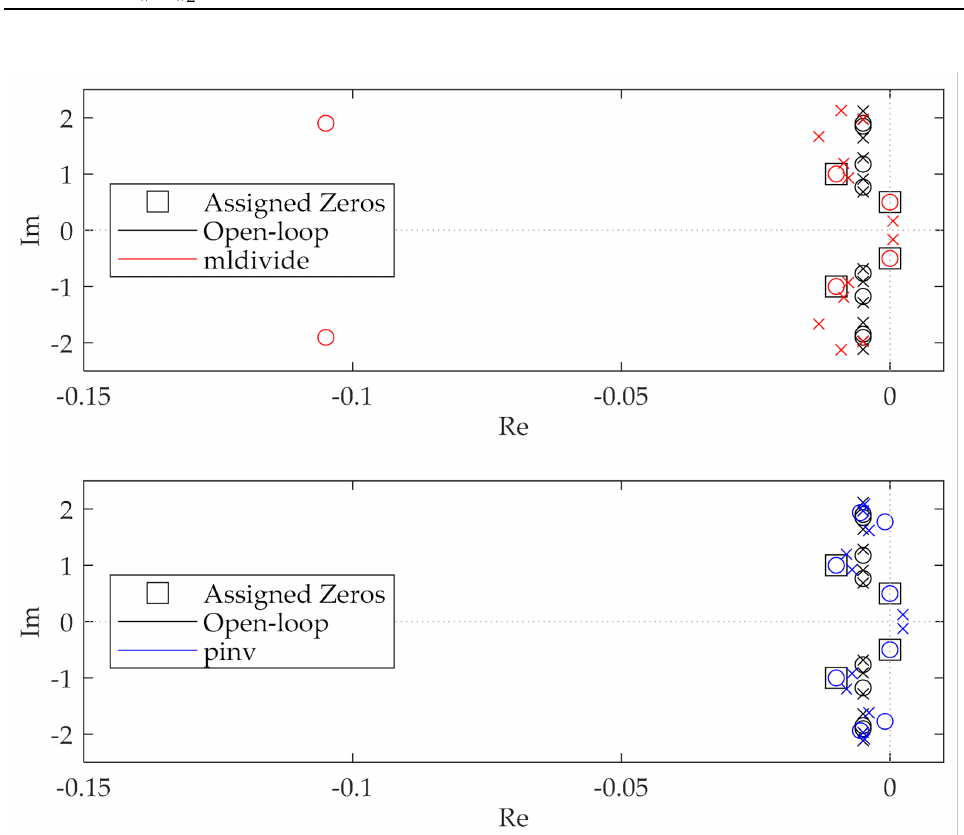
Figure 9. Open-loop and closed-loop pole-zero maps of receptance h 3,4 (j ω ) with different